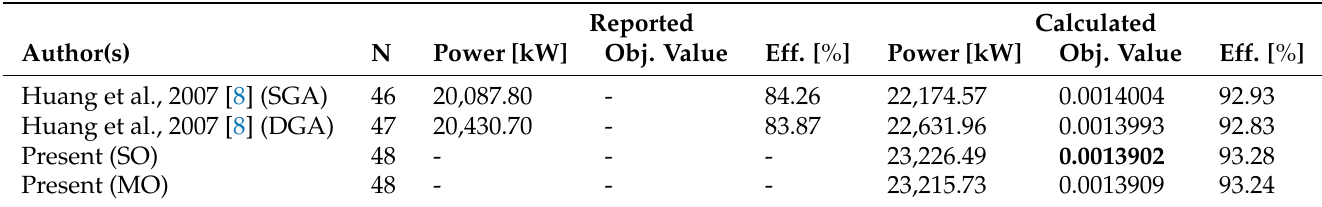
Table 5. Result comparison for case 3.